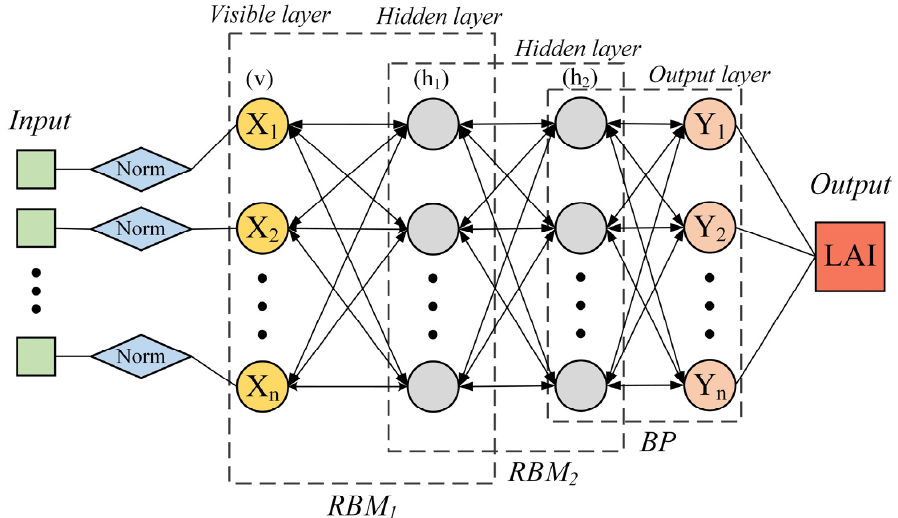
Figure 3. DBN structure, where “norm” represents the normalization of the input data, and “v” and “h” represent the visible layer and hidden layer of each RBM layer, respectively.